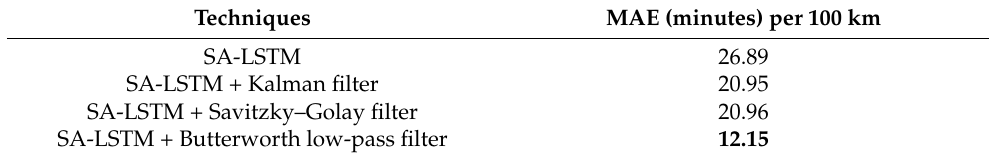
Table 5. Performance report of the comparison of SA-LSTM and SA-LSTM with a filter